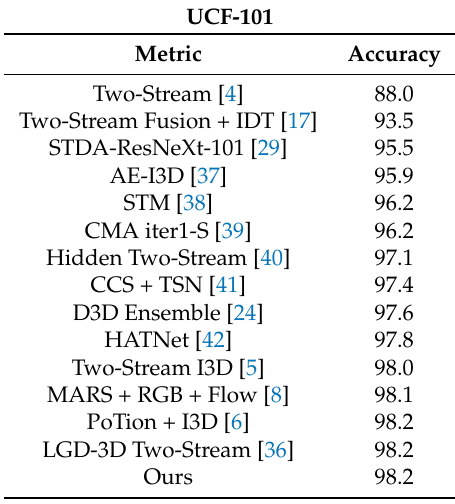
Table 6. Comparison with State-of-the-Art Methods on UCF-101 (Accuracy Top-1).